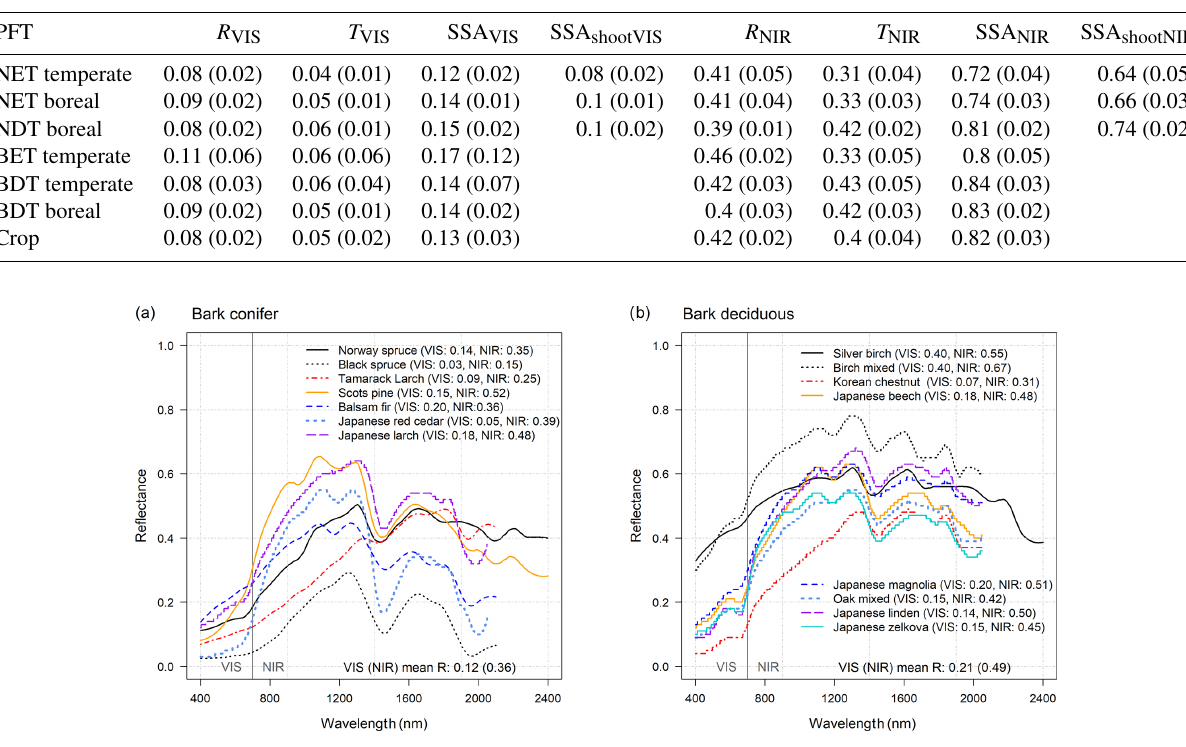
Figure 4. Bark reflectance ( R (λ) ) of (a) coniferous, and (b) deciduous species in VIS (400–700nm) and NIR (701–2400nm) wavelength regions. The mean bark reflectance values in VIS and NIR are provided at the bottom of the images and are calculated as an average across the species mean (the mean across all bark values R VIS = 0 . 17 and R NIR = 0 . 43). Note that all VIS and NIR averages of R (λ) and T (λ) were weighted with solar irradiance spectra (SI (λ) )